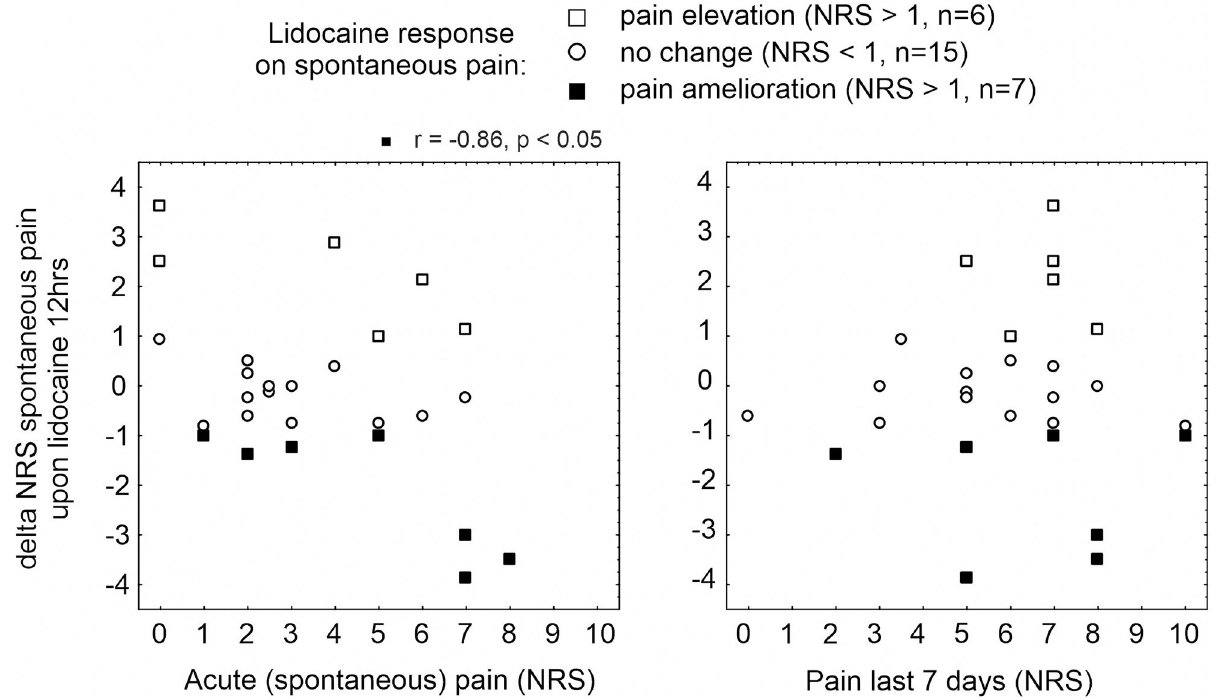
Fig 4. Data correlation analysis. Spearmans rank correlation between pain reduction upon 12 hours lidocaine 5% patch (delta NRS, -10 to 10) and magnitude of acute (spontaneous) pain (left panel) or maximum pain perceived during 7 days (right panel), respectively, in patients reporting a pain reduction (“pain amelioration”, solid squares, p < 0.05), pain facilitation (“pain elevation”, open squares) or no alteration of acute pain (“no change”, open circles). Note that 3 patients who reported about a pronounced beneficial lidocaine effect also had high scores of acute (spontaneous) and maximum 7-days